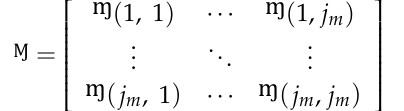
Figure 2. Illustration of the phases of the research study. Table 1. List of key mathematical